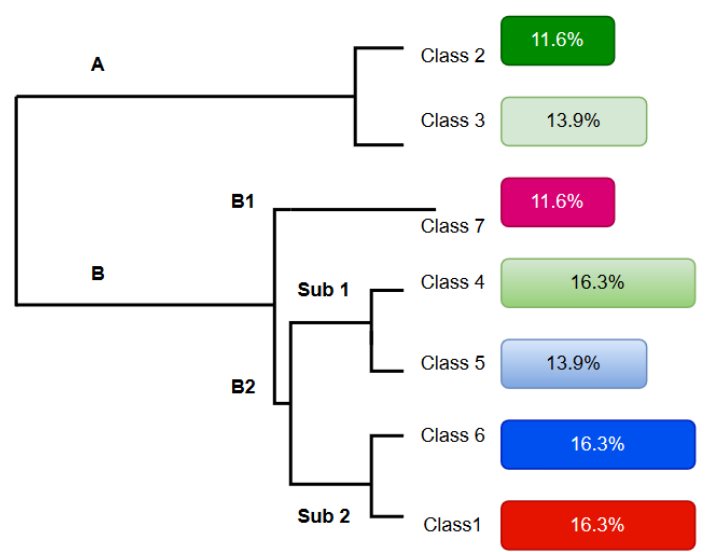
Figure 1. Grouping of classes by cluster